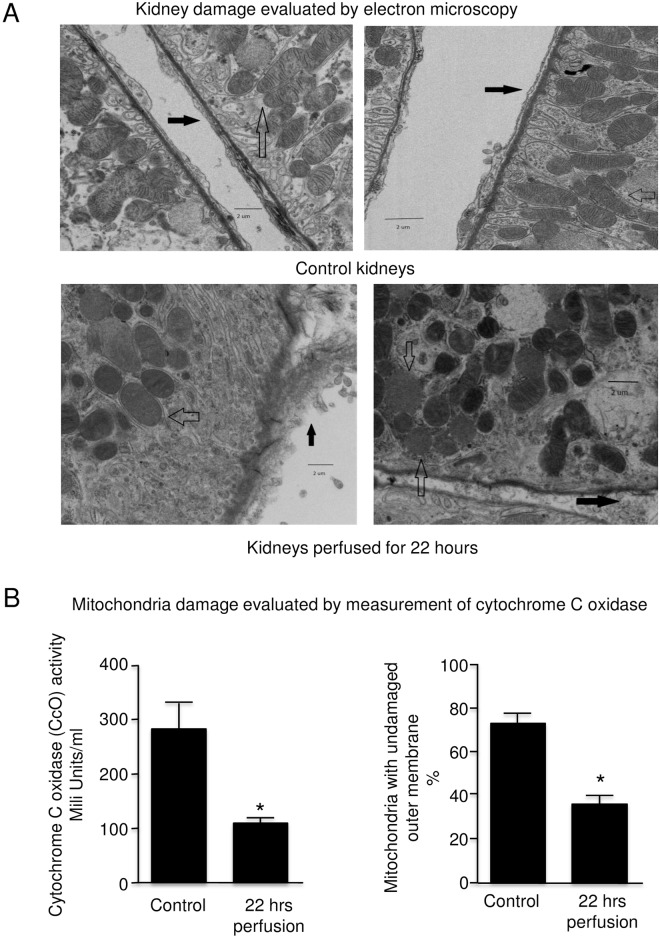
Representative electron micrographs of rat kidneys and comparison of mitochondrial damage at the time of retrieval and after 22 hours of machine cold perfusion. (5K magnification).A: Clear arrows = mitochondrial swelling and loss of detail at 22 hours Dark arrows = swelling and detachment of the tubular endothelium at 22 hours. B (n = 4). Left panel = cytochrome c oxidaseRight panel = percent undamaged outer membrane of mitochondria. Error bars represent Standard Error of the Mean (SEM). * p<0.05 using Student’s T test.